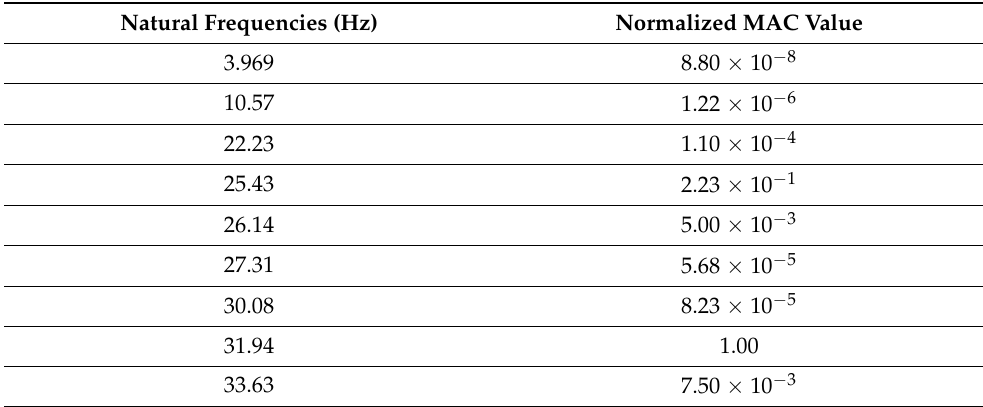
Figure 11. ( a ) Reference eigenvector (vertical bending mode) and ( b ) matching eigenvector from a set of test eigenvectors. Table 3. Modal assurance criteria (MAC) values of test eigenvectors with respect to reference eigenvectors (see Figure